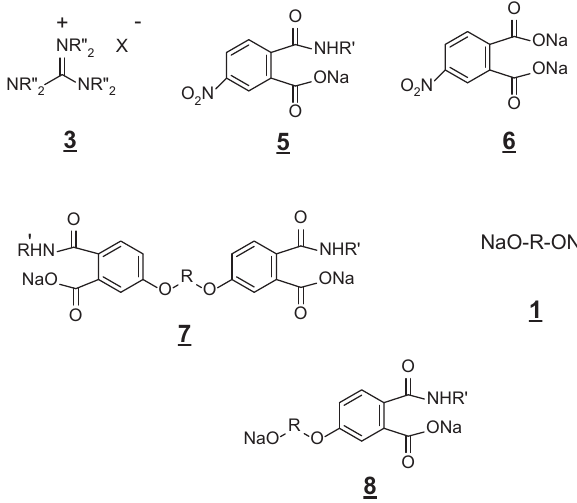
Figure 1 Organic substituents present in the wastewater